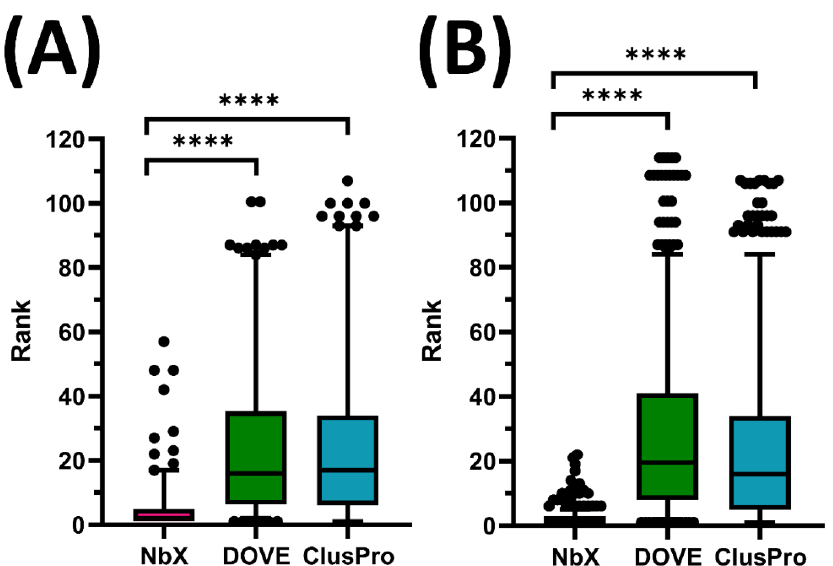
Figure 1. Comparison of re-ranking of native-like Nb pose between NbX, DOVE and ClusPro in ( A ) test set and ( B ) training set. Whole populations (N test = 200 and N train = 660) of ranking of native-like Nb pose from the 5-fold cross-validated were shown in boxplots. The upper and lower whiskers represent 95th and 5th percentile ranking, respectively. The dots represent outliers. Annotations for p value in t -Test are as follow, ns: 0.05 < p ≤ 1.00; **** p ≤ 0.0001.